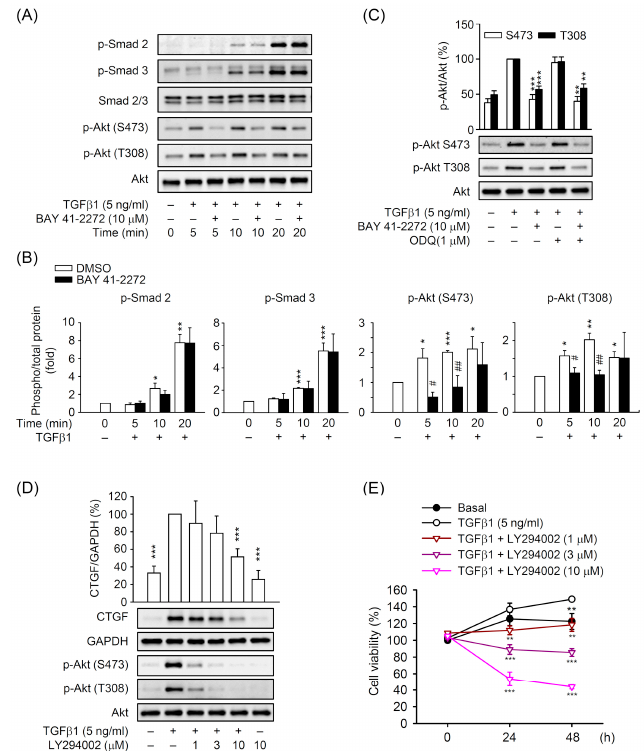
Figure 8. The BAY 41-2272-inhibited CTGF expression was dependent on Akt signaling in TGF β 1- activated HSCs. HSCs were pretreated with or without ODQ (1 μ M) for 15 min. HSCs were sequentially incubated with ( A – C ) BAY 41-2272 (10 μ M) or ( D , E ) LY294002 (1–10 μ M) Akt signaling inhibitor for 30 min before activation by TGF β 1 (5 ng/mL) for another ( A , B ) 5–20 min, ( C , D ) 10 min, or ( E ) 24–48 h. ( A – D ) Protein levels were determined by Western blot using antibodies against p- Smad2, p-Smad3, Smad2/3, p-Akt (S473 or T308), Akt, CTGF, or GAPDH. ( E ) Cell viability was measured using the WST-1 assay and monitored spectrophotometrically at 450 nm. All data are expressed as mean ± SD ( n = 3). * p < 0.05, ** p < 0.01, *** p < 0.001 compared with the basal ( B ) or TGF β 1 alone ( C – E ). # p < 0.05, ## p < 0.01 compared with the corresponding DMSO